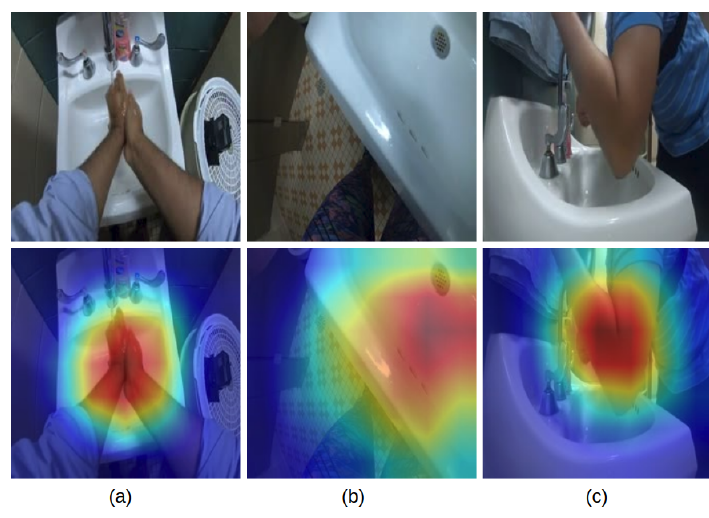
Figure 10. Grad cam [47] results of ( a ) chest cam: rub hand with water, ( b ) chest cam: touch faucet with elbow, ( c ) wall cam: touch faucet with elbow, when applied to the respective